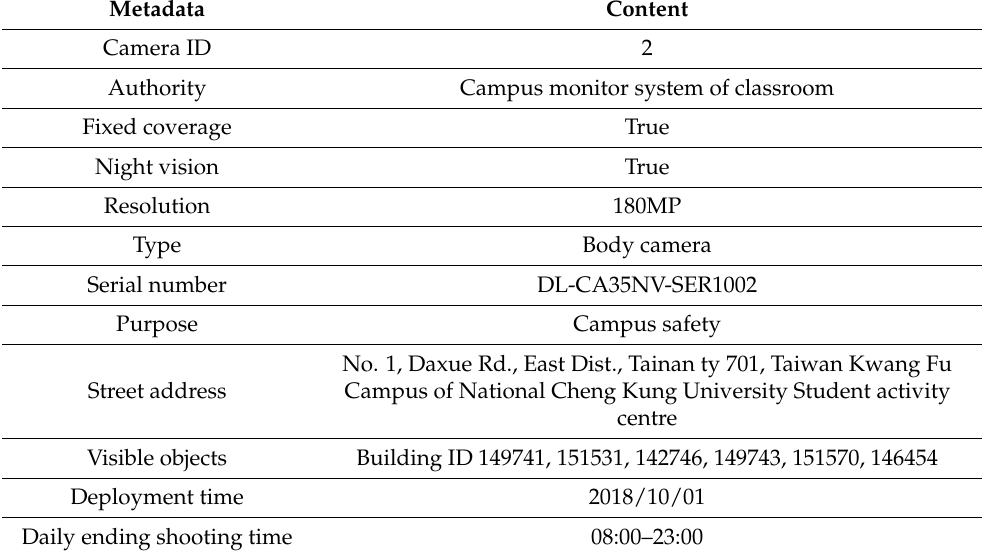
Table 6. Camera 2 CCTV’s metadata